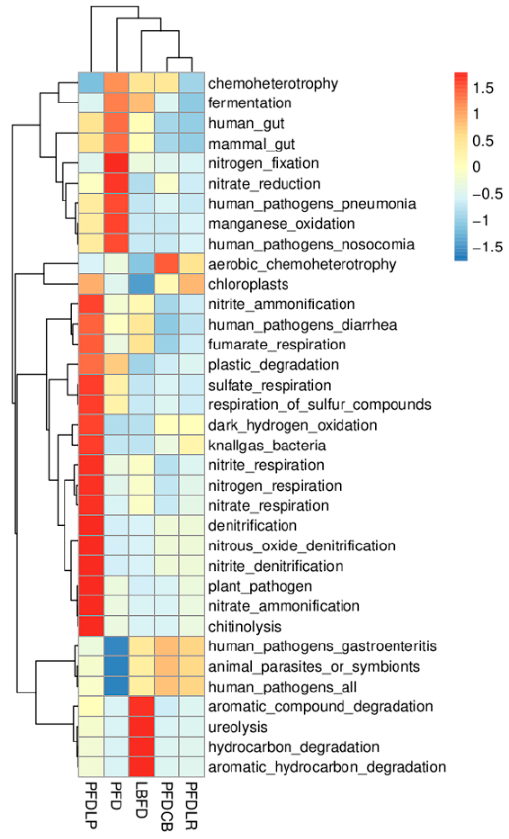
Figure 11. Heatmap showing the relative abundances of KEGG ortholog groups of mandarin fish intestinal microbial populations in different feeding groups (LBFD, PFD, PFDCB, PFDLR and PFDLP) after being fed for 28 days. The heatmap was made based on Tax4Fun functional annotations, and the color intensity indicates the abundance information. Abbreviations: LBFD, live bait fish feeding group; PFD, pellet-feed feeding group with probiotics free; PFDCB, pellet-feed feeding group with C. butyricum plus; PFDLR, pellet-feed feeding group with L. rhamnosus plus; PFDLP, pellet-feed feeding group with L. plantarum plus.